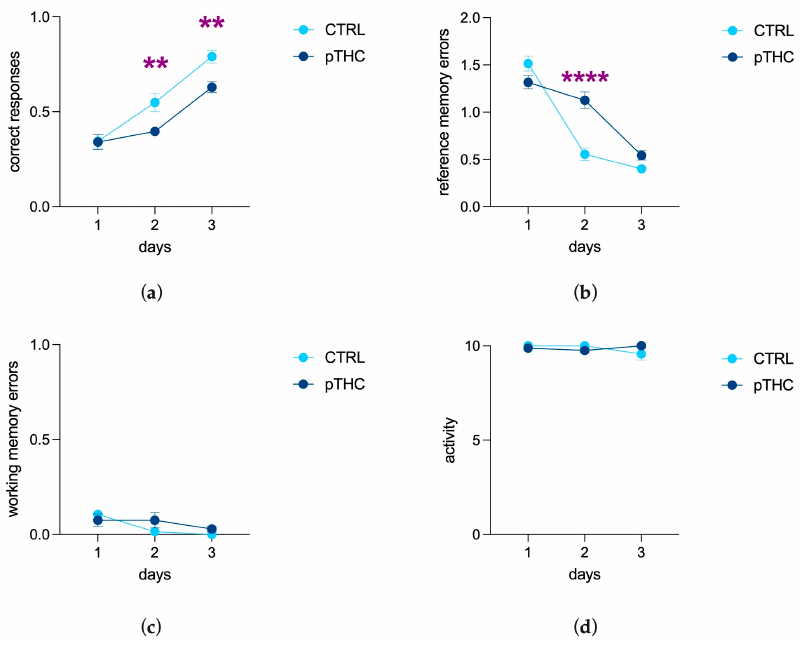
Figure 5. Effect of prenatal THC exposure (2 mg/kg) on spatial memory of the adolescent male rat offspring in the spatial task of the Can test: ( a ) pTHC decreased the correct responses of adolescent male rats on days 2 and 3 and ( b ) induced an increase in reference memory errors on day 2 of adolescent male rats compared to controls. ( c ) No effect of prenatal THC treatment was detected in working memory errors and ( d ) activity. Each bar represents the mean of n = 9 rats in the CTRL group and n = 10 rats in the pTHC group; error bars indicate SEM. ** p < 0.01; **** p < 0.0001; CTRL = male rat offspring prenatally exposed to Veh; pTHC = male rat offspring prenatally exposed to THC. The offspring’s ability to discriminate a different object among identical ones,